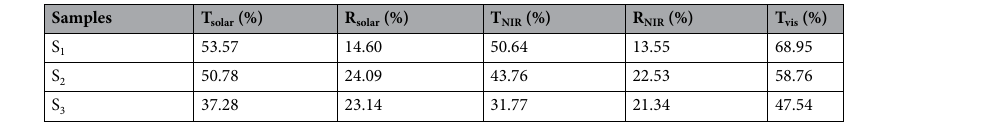
Table 2. Average transmittance and reflectance of samples in visible, solar, and NIR regions.